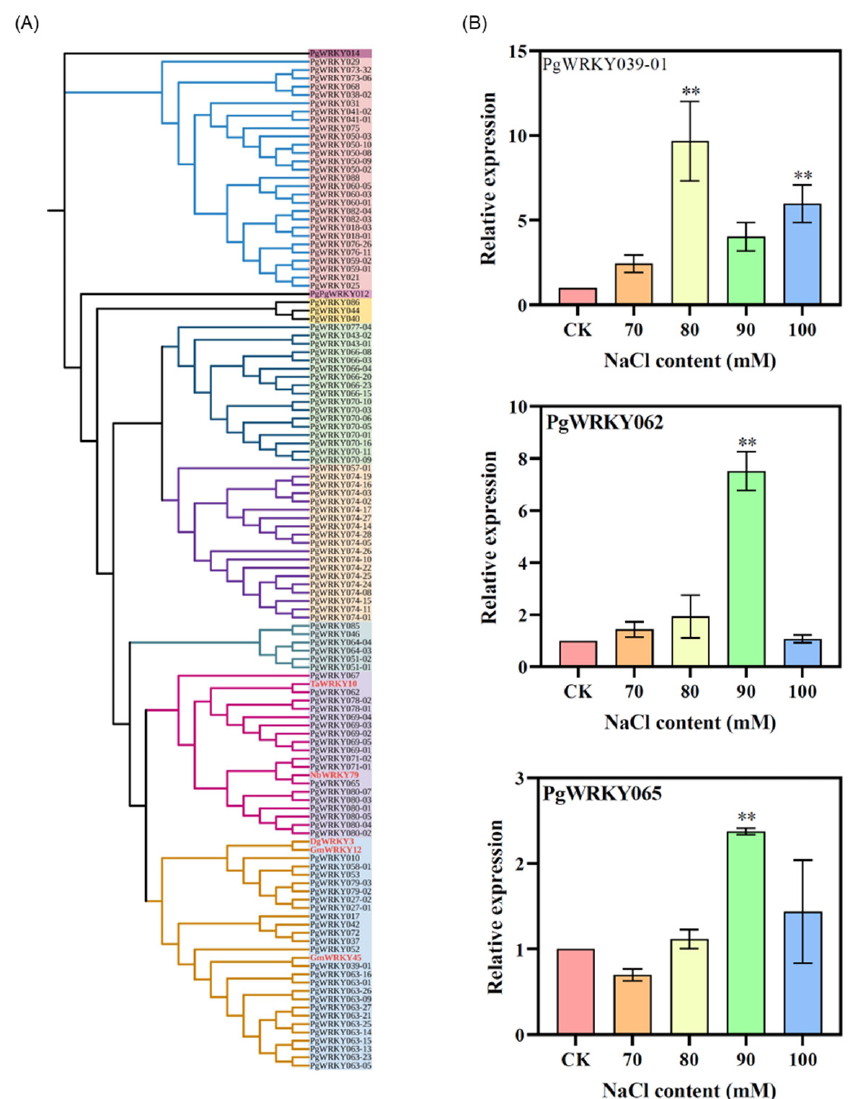
Figure 9. The expressions analysis of PgWRKY39-01, PgWRKY062, and PgWRKY065 genes in the ginseng adventitious roots treated with salt stresses using the RT-qPCR. ( A ) The evolutionary tree of PgWRKY genes with five WRKY genes known to have salt stress function, included TaWRKY10 , DgWRKY3 , NbWRKY79 , GmWRKY12 , and GmWRKY45 genes. ( B ) The expression of PgWRKY39-01 , PgWRKY062 , and PgWRKY065 genes in the ginseng adventitious roots treated with and without salt stresses. The 2 − ∆∆ Ct method was used to evaluate the relative expression, and the expression levels of genes in the control were defined as “1”. Each value is the average of three replicates, and error bars represent ± SD. “**” Significant at p ≤ 0.01; “*” significant at p ≤ 0.05; the remaining is not significant at p ≥